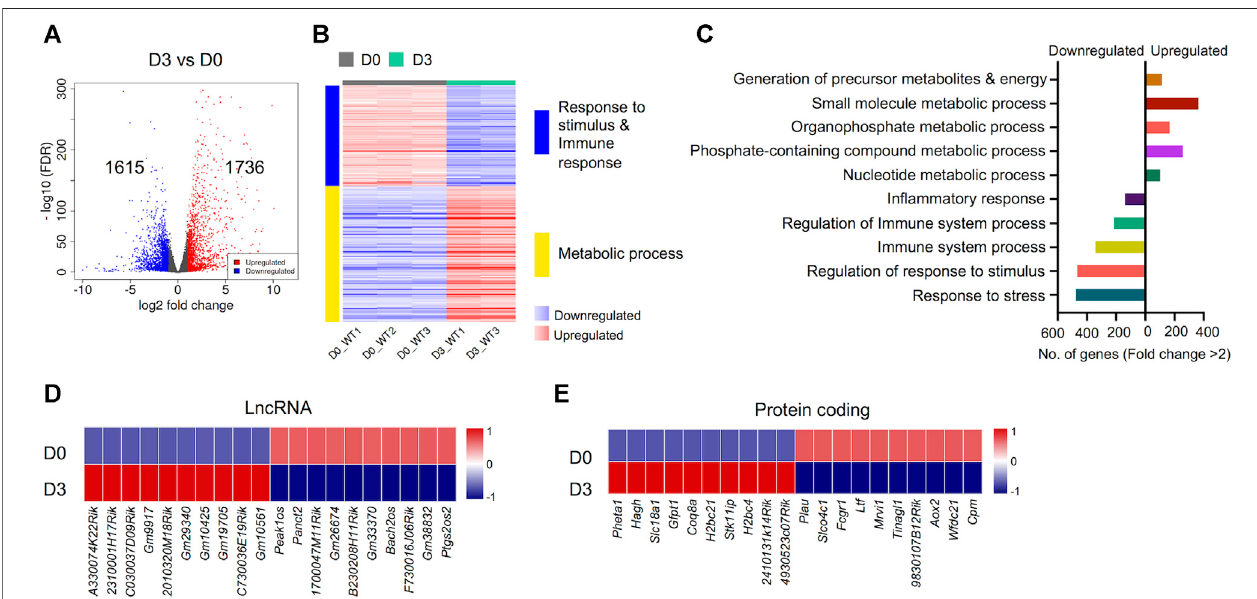
FIGURE 3 | Differentially regulated genes in early osteoclast differentiation. The transcriptomes of osteoclast precursors (D3) were compared with bone marrow derived macrophages (BMDM) (D0). (A) Volcano plot represents signi fi cantly upregulated (red), downregulated (blue) or genes with unchanged expression levels (gray) between D3 and D0 comparison. (B) Heatmap shows gene enrichment and associated pathways in D3 versus D0. (C) Bar plot shows the numbers of genes correspondingtosigni fi cantlyup/downregulatedfunctionalpathwaysfromgeneontologyenrichmentanalyses.Heatmapsshowthegeneexpression(Z-scores)of